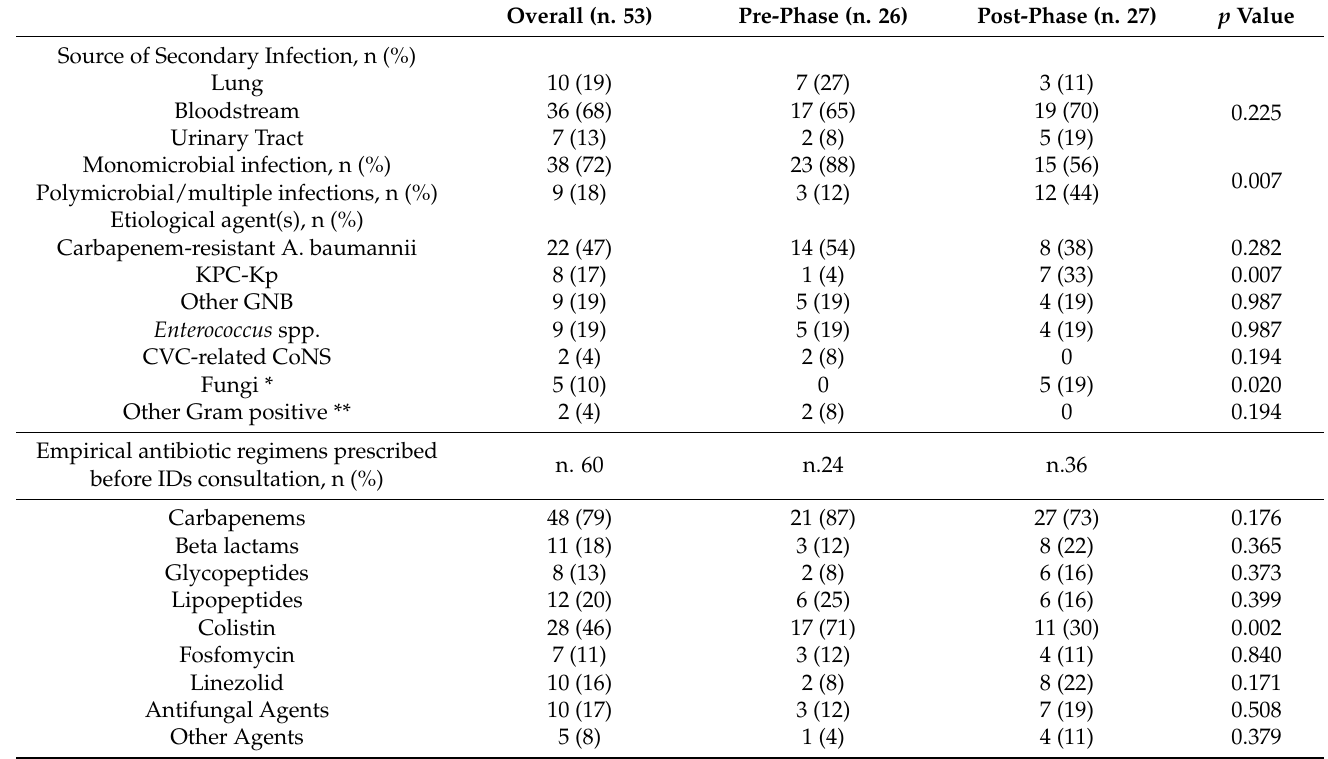
Table 2. Clinical characteristics of secondary infections and prescribed antimicrobials. Overall (n.